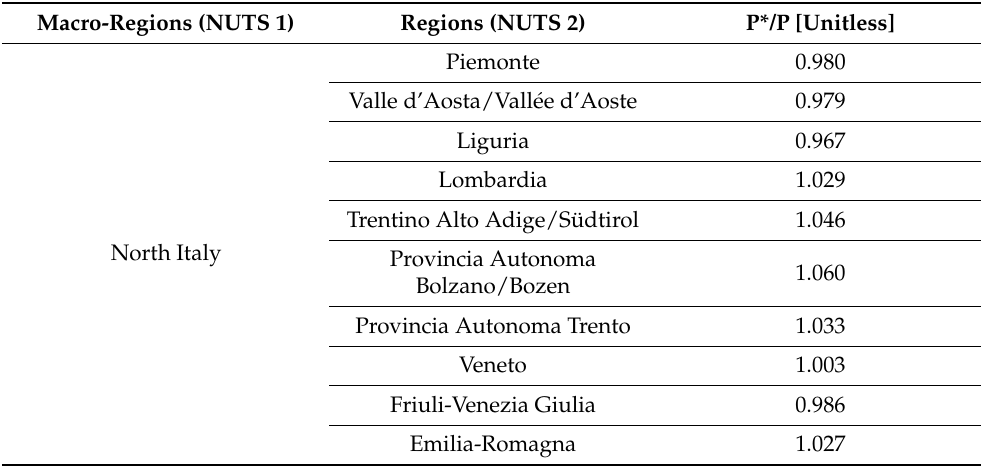
Table A1. Ratio between 2021 total population (P*) and 2011 total population according to the 2011 population census (P) based on data from ISTAT (http://dati.istat.it/Index.aspx, accessed on 2 September 2022) for the regions of north, central, and south and insular